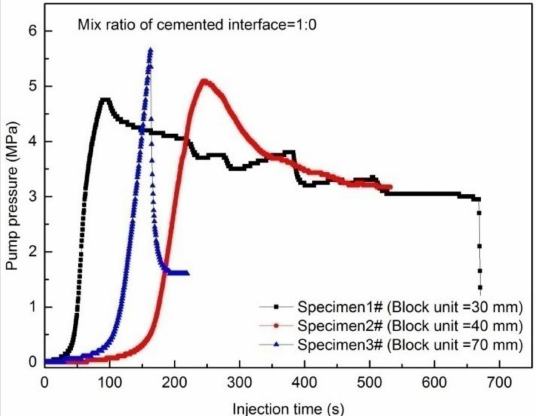
Figure 6. Plots of pump pressure against injection time for model blocks with dense, medium, and sparse DFN (the mix ratio of the cement interface is 1:0).